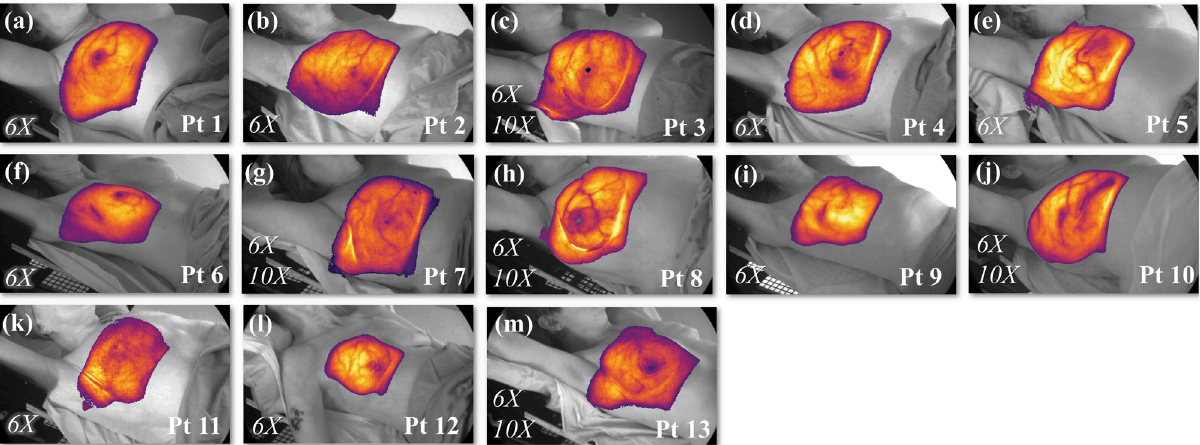
Fig. 3 Cherenkov image data from 13 whole-breast radiotherapy patients. Patients 1 ( a ), 2 ( b ), 4 ( d ), 5 ( e ), 6 ( f ), 9 ( i ), 11 ( k ), and 12 ( l ) had prescribed radiation treatments using only 6 MV energy beams (6X), and treatments for Patients 3 ( c ), 7 ( g ), 8 ( h ), 10 ( j ), and 13 ( m ) included both 6 and 10 MV beams (6X/10X), indicated in the bottom left corner for each patient thumbnail. The recorded Cherenkov emission is overlain in color on the recorded background image (grayscale), which is captured in real time. In ( h ), a small patch bolus was used as buildup material over the surgical scar (right lateral, region of higher intensity in the lateral mammary fold) 29 . In each thumbnail, Cherenkov fi elds have undergone spatial and temporal median fi ltering, and thresholding based on closest match to the treatment fi eld. The images presented correspond to different color scales to optimize dynamic range